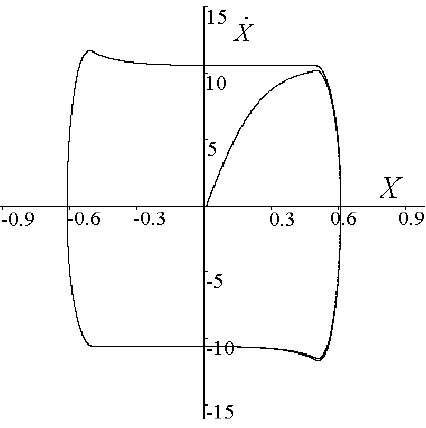
Fig. 4. Phase portrait of the system with a fixed clearance e = 0 . 001 via numerical solution.